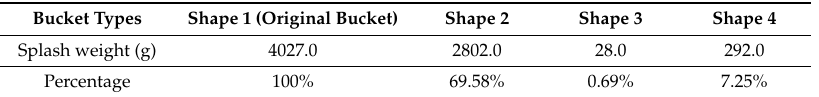
Table 2. The weight of splash water for different bucket types in the physical model